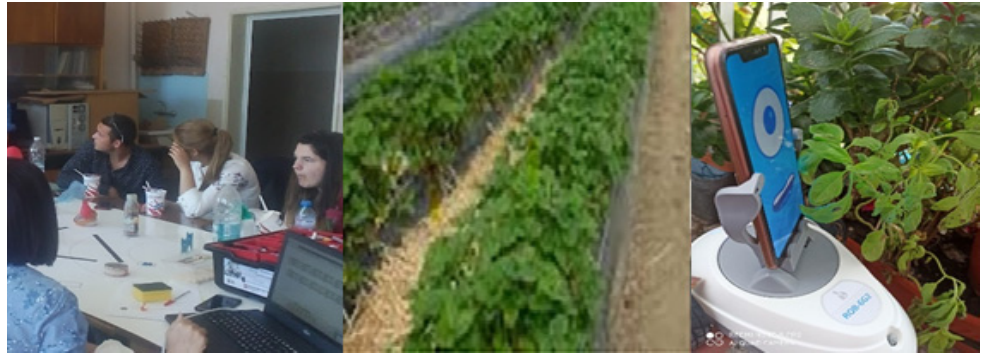
Figure 17. Application of the Robobo robot in a school STEM greenhouse.